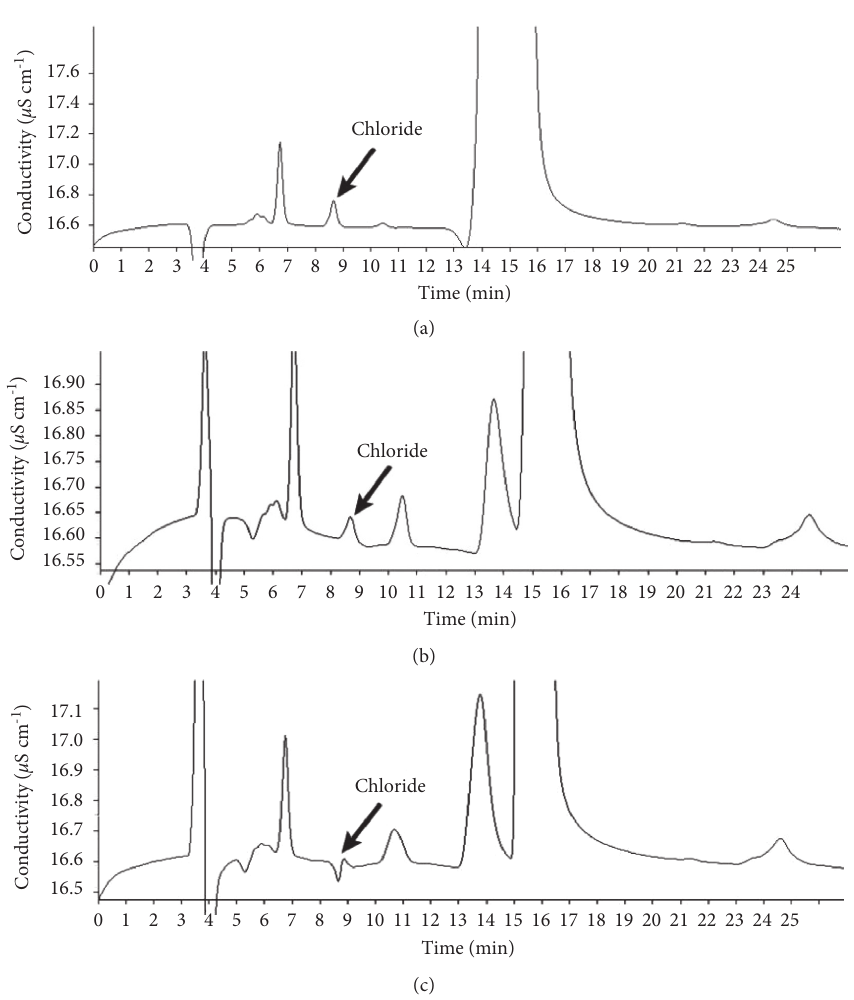
− 1 NH 4 OH, and (c) 100mmolL 4 OH as absorbing